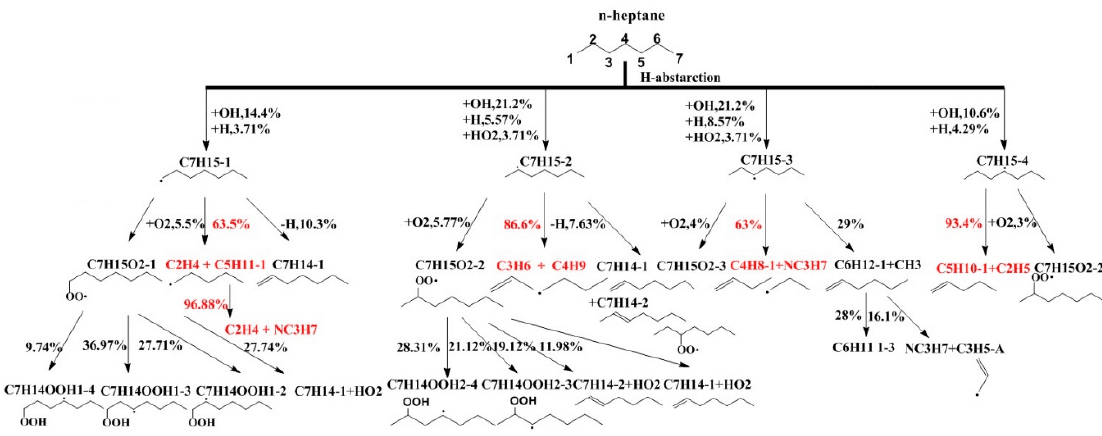
Figure 15. N-heptane reaction path analysis, temperature 1250 K, pressure 4000 kPa, equivalent ratio